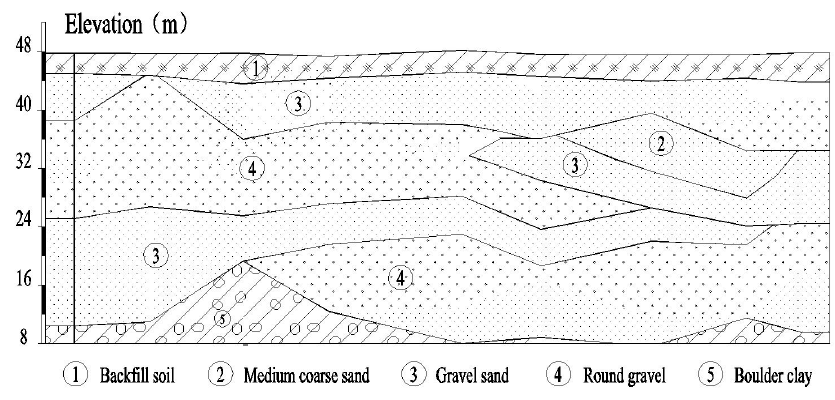
Figure 5. Geological profile of the soil. Table 1. The results of super heavy dynamic cone penetration test.